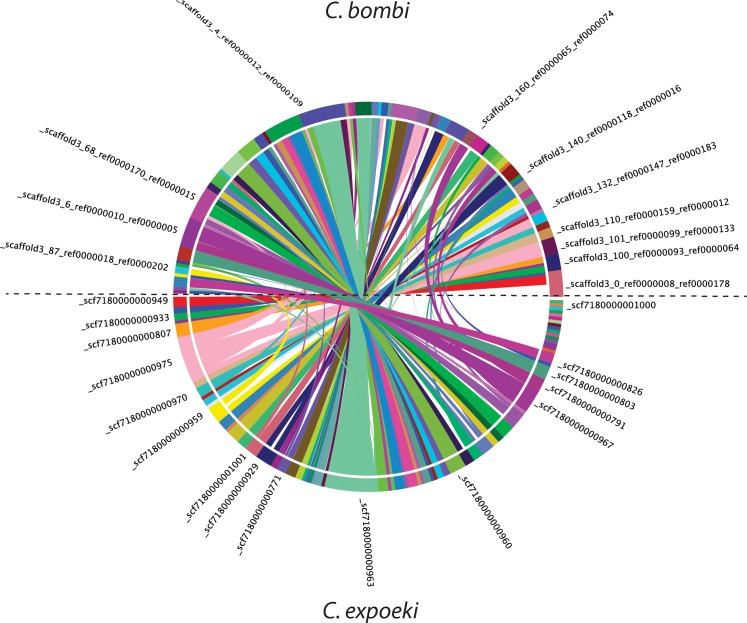
Synteny.Synteny graph between C. bombi and C. expoeki genomes generated with SyMap 4.2 [59,60]. The plot shows all syntenic blocks between the scaffolds of C. expoeki (bottom half of the circle) mapping to scaffolds of C. bombi (upper half of the circle). Each coloured block indicates a scaffold of the respective genome. Syntenic blocks are linked with lines in the colour of the C. expoeki scaffolds. For illustrative purposes, a few scaffolds (as named in this study) are indicated at their approximate position in the circle.